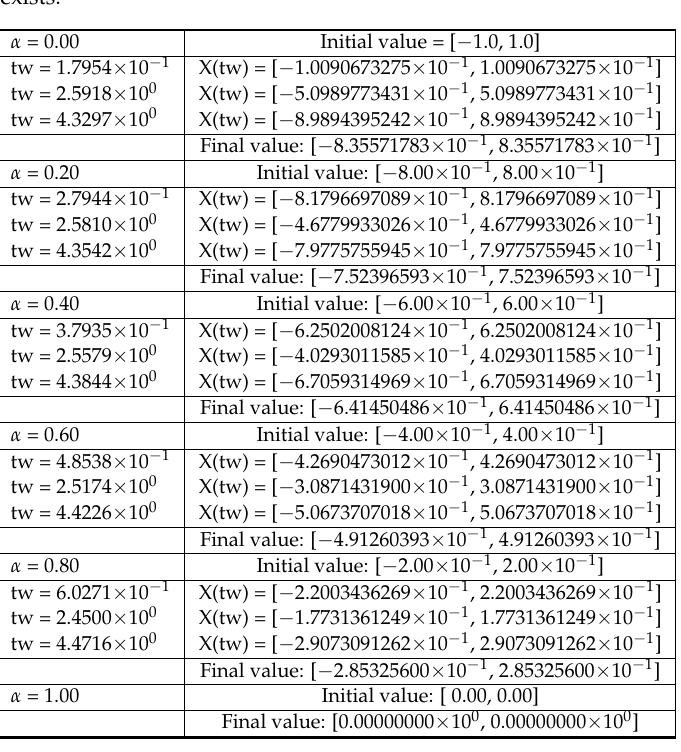
Table 3. (Interval-valued problem IDE2-a): For five values of α ∈ { 0,0.2,0.4,0.6,0.8 } , the three switching points tw corresponding to Meth=1 are given in the first column; the second column contains the interval-valued solution X ( tw ) = [ x − α ( tw ) , x + α ( tw )] . If α = 1, the solution is single-valued and no switching point exists.